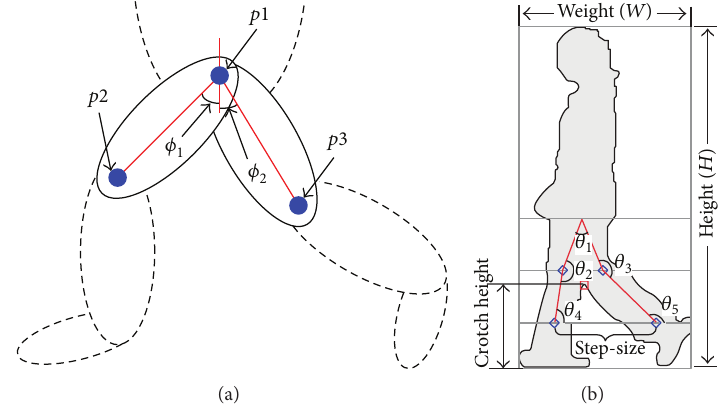
Figure 8: (a) Computation of joint angular trajectory. (b) Nine extracted gait